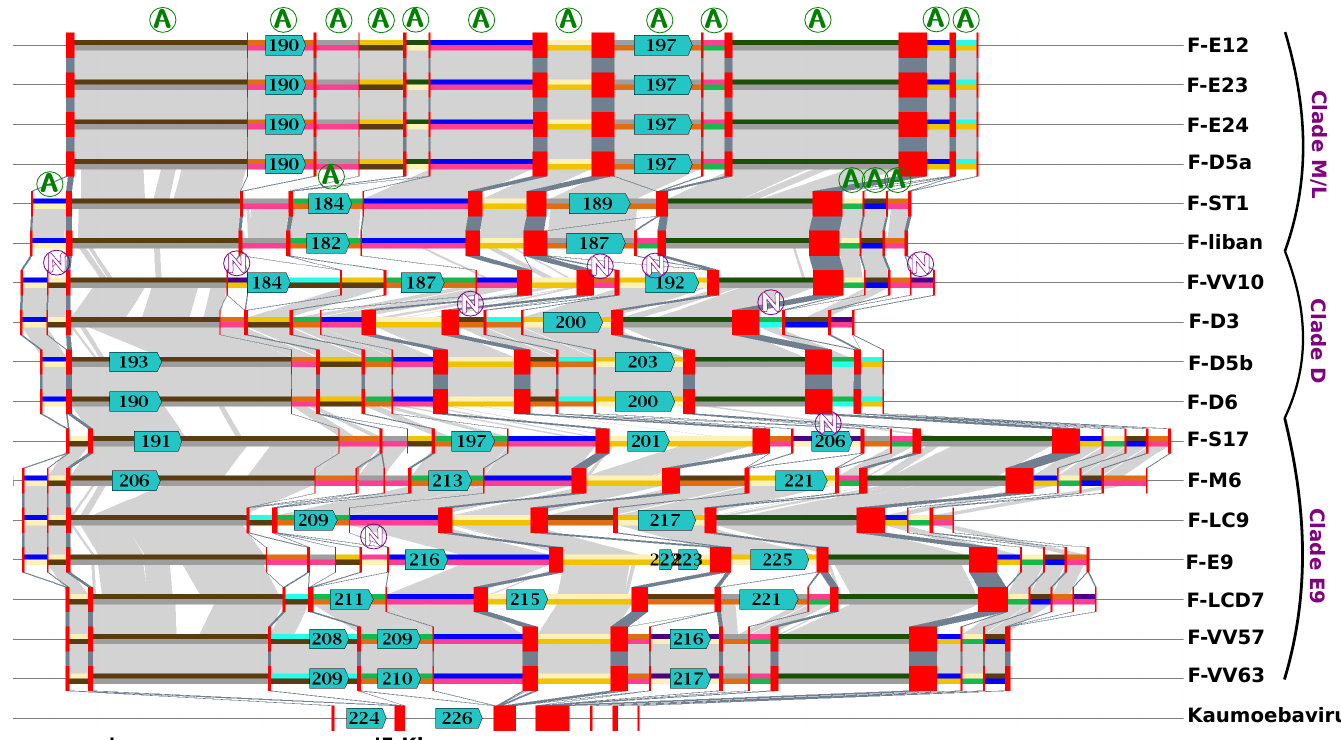
Figure 3. Evolution of the major capsid protein (MCP) gene structure in FVs and Kaumoebavirus (KV). The figure shows a graphical representation of the FV and KV MCP gene alignment. Exons and introns of the MCP genes are shown by red rectangles and 2-colour segments, respectively. Introns represented by the same 2-colour code are orthologous (i.e., share sequence similarity and position relative to the MCP coding sequence). A circled “A” marks orthologous introns that were present in the last FV common ancestor (i.e., introns shared by any virus from clade M / L and any virus from clades D and / or E9). Inversely circled “N”s indicate introns that have no evidence of being present in the last FV common ancestor. Light and dark grey areas indicate significant nucleotide similarity between introns and between exons, respectively. Predicted ORFs with significant protein similarity to group I intron endonucleases are shown with blue arrows with a number inside indicating the ORF id in the respective genome annotation.